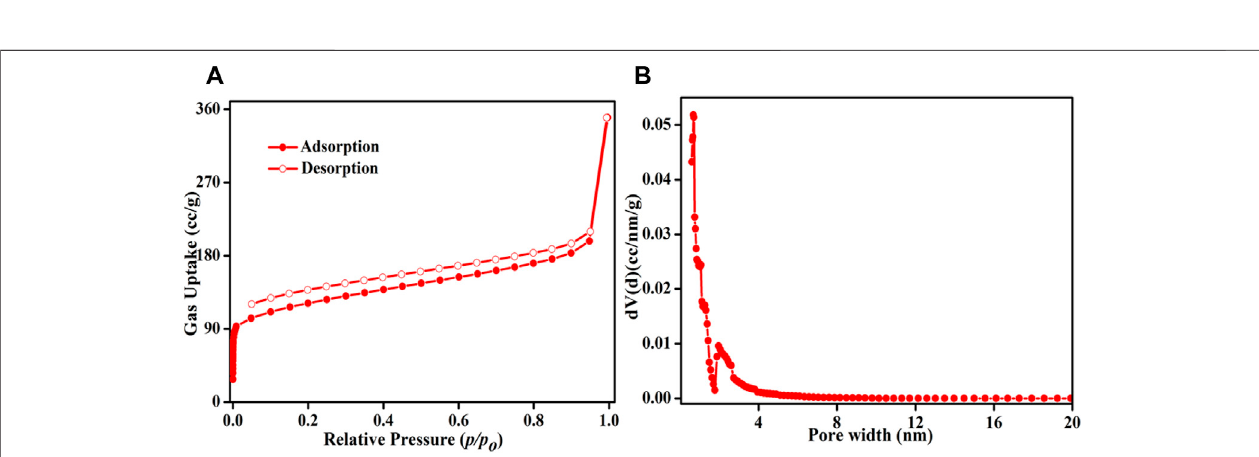
FIGURE 2 | (A) N 2 adsorption – desorption isotherms carried out at 77 K for HMP-TAPA. Closed circles represent adsorption and open circles for desorption. (B) Pore size distribution in HMP-TAPA.